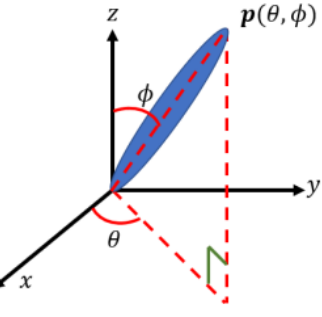
Figure 6. Vector representation of a single fiber’s orientation.